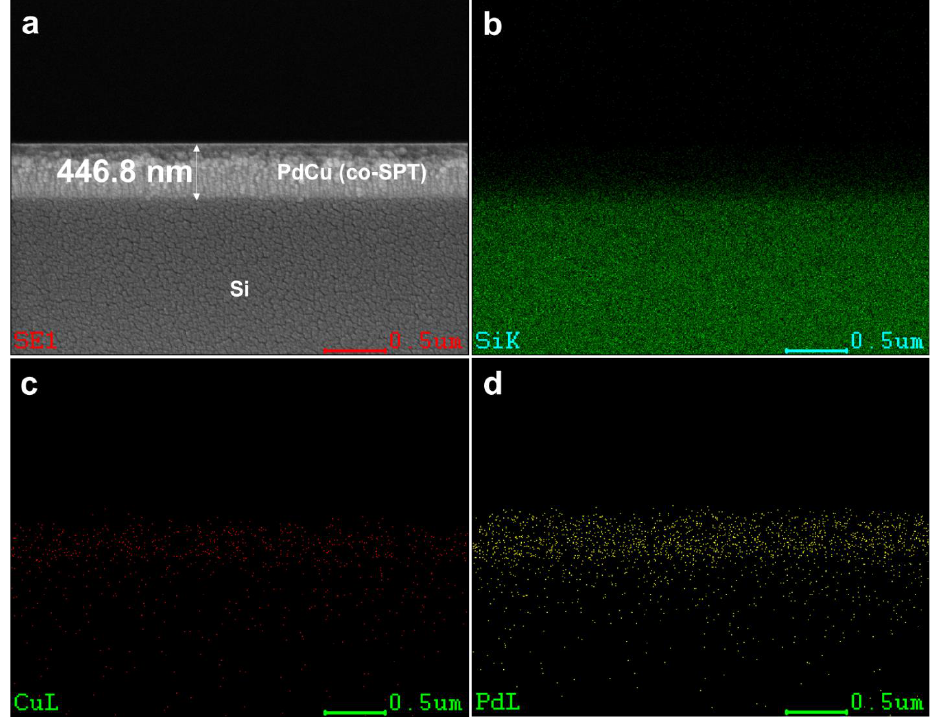
Figure 5. Cross-section ( a ) SEM image of PdCu(co-SPT)/Si, and EDS mapping of ( b ) Si, ( c ) Cu, and Figure 5. Cross‑section ( a ) SEM image of PdCu(co‑SPT)/Si, and EDS mapping of ( b ) Si, ( c ) Cu, and ( d ) Pd. ( d )